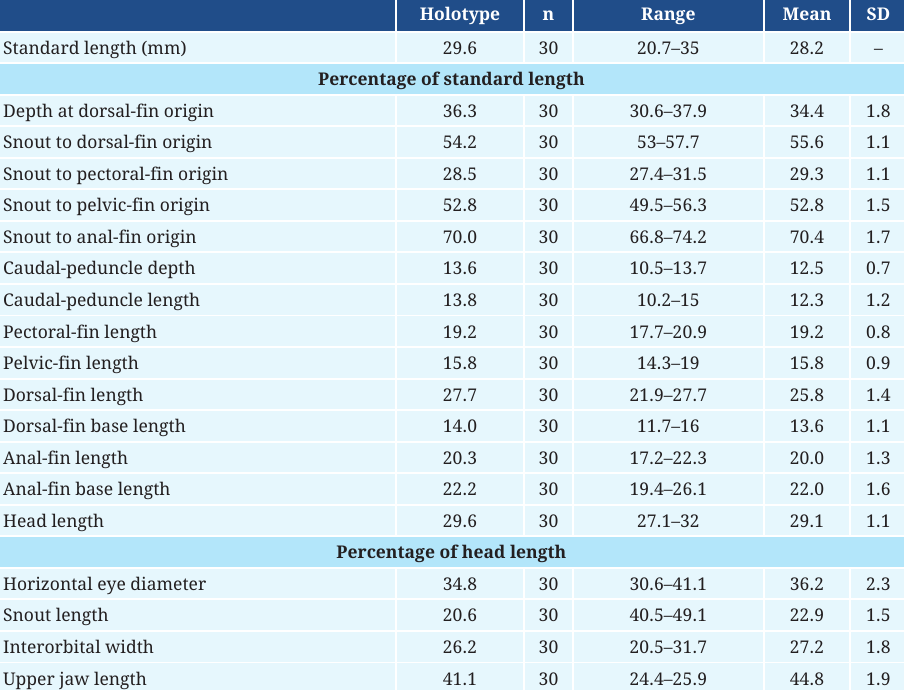
TABLE 1 | Morphometric data of Hyphessobrycon comodoro . Range includes the holotype. SD = Standard